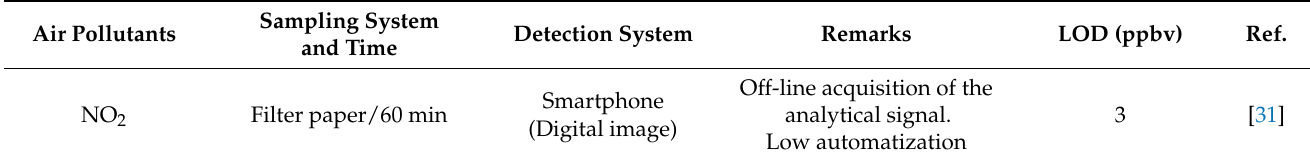
Table 3. Comparison among other analytical platforms employed for gaseous NO 2 and/or O 3